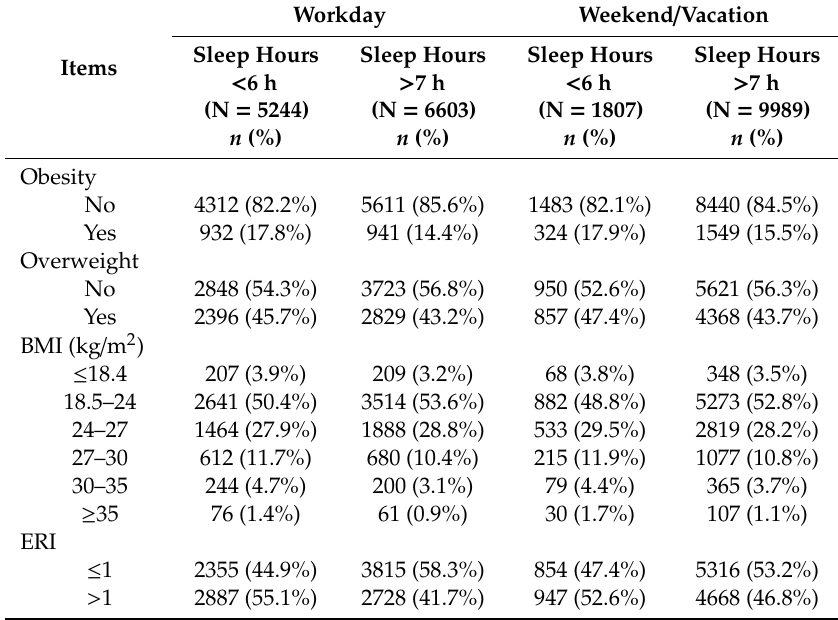
Table 2. Two groups of sleep duration for workdays and weekends / vacations and association with obesity, overweight, BMI, and e ff ort–reward imbalance (ERI).